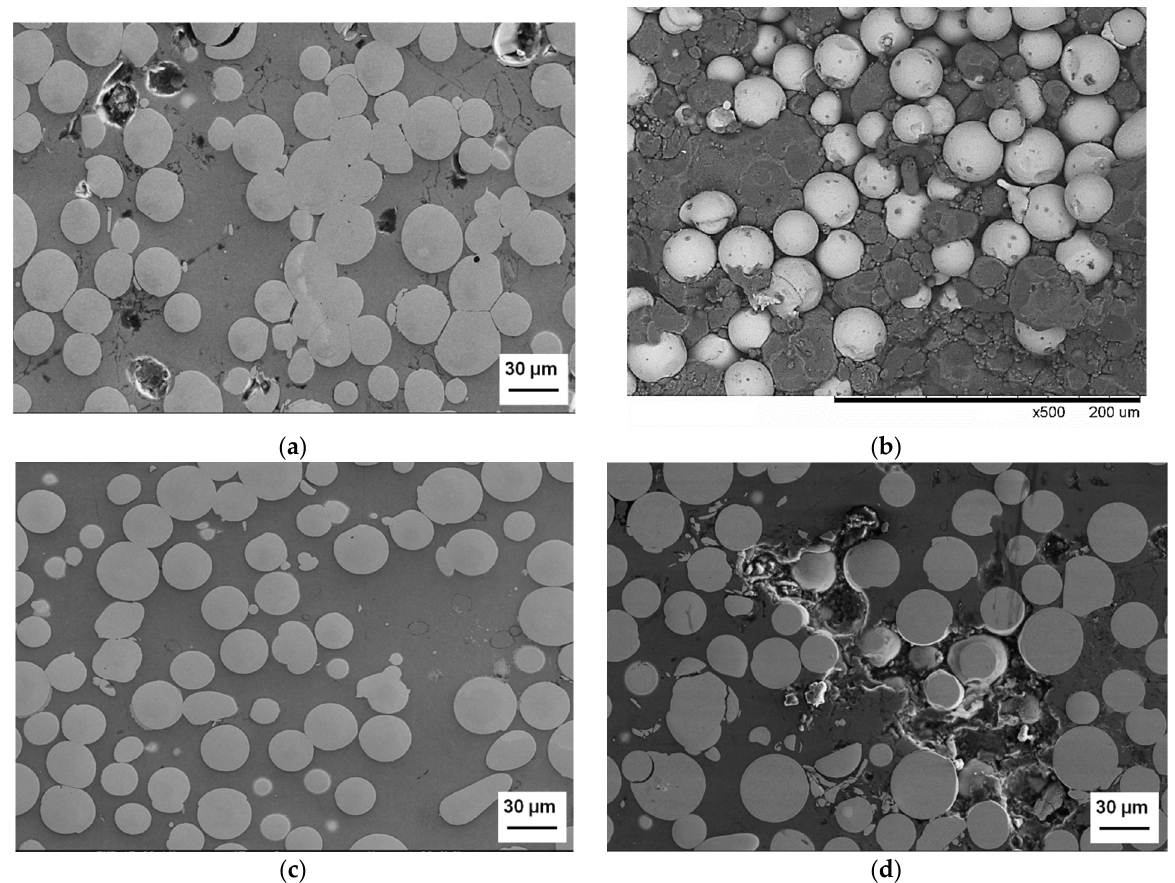
Figure 10. Microstructure of the spark plasma sintered composites obtained from ( a ) Al (coarse)– glassy Fe 66 Cr 10 Nb 5 B 19 , ( b ) Al (coarse)–crystalline Fe 62 Cr 10 Nb 12 B 16 mixtures, ( c ) Al (fine)–glassy Fe 66 Cr 10 Nb 5 B 19 , ( d ) Al (fine)–crystalline Fe 62 Cr 10 Nb 12 B 16 mixtures. ( a , c , d ) Micrographs of the polished cross ‐ sections, SE images; ( b ) micrograph of the fracture surface, BSE image. Reprinted from [82]. This article is an open access article distributed under the terms and conditions of the Creative Commons Attribution (CC BY) license (https://creativecommons.org/licenses/by/4.0/).